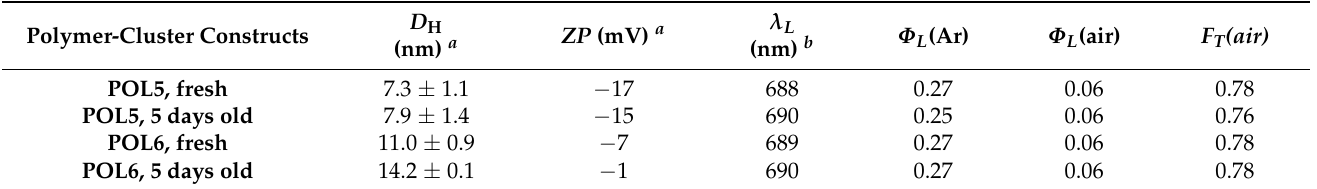
Table 4. Physico ‐ chemical and photophysical characteristics of fresh solutions of polymer ‐ cluster constructs in PBS and their stability after 5 days. Table 4. Physico-chemical and photophysical characteristics of fresh solutions of polymer-cluster constructs in PBS and their stability after 5 days.